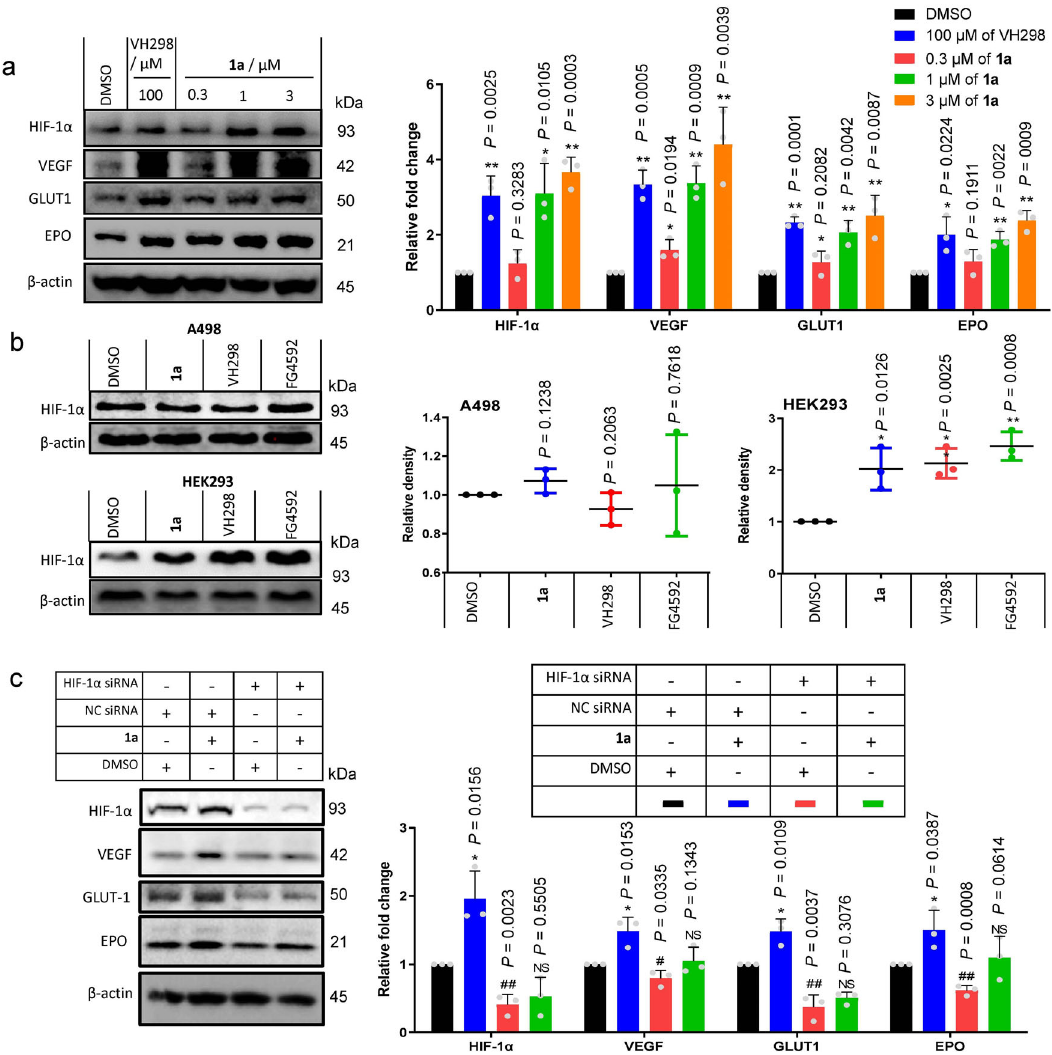
Fig. 3 Effect of complex 1a on HIF-1 α target gene products in cellulo . a Effect of complex 1a on speci fi c proteins (GLUT1, VEGF, and EPO) mediated by HIF-1 α in HEK293 cells. HEK293 cells were treated with 1a for 2 h. Cell lysates were collected and analyzed by Western blotting. b Complex 1a has no effect on HIF-1 α accumulation in a VHL null cancer cell line. A498 (VHL-null), or HEK293 cells were treated with 1% DMSO, 1a (3 μ M), VH298 (100 μ M), and FG-4592 (100 μ M) for 2 h before lysis. c Effect of complex 1a on EPO, GLUT1, and VEGF levels in HEK293 cells with or without HIF-1 α knockdown. Left: The expression levels of EPO, GLUT1, and VEGF in HEK293 cells with or without knockdown HIF-1 α in the presence or absence of 1a . Right: Densitometry analysis of EPO, GLUT1, and VEGF levels on the Western blot. HIF-1 α siRNA (sense, 5 ′ -CUGAUGACCAGCAACUUGA-3 ′ , antisense, 5 ′ -UCAAGUUG CUGGUCAUCAG-3 ′ ). Negative control (NC) siRNA (sense, 5 ′ -UAGCGACUAAACACAUCAA-3 ′ , antisense, 5 ′ -UUGAUGUGUUUAGUCGCUA-3 ′ ). Data are expressed as means ± SD ( n = 3 independent experiments), P values were calculated using a two-sided t -test. # P < 0.05, ## P < 0.01 HIF-1 α siRNA